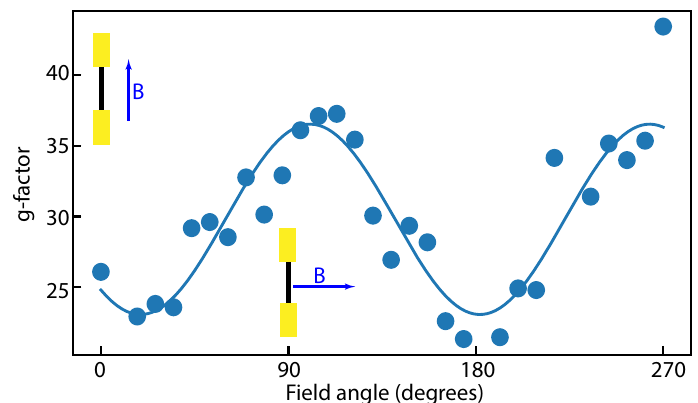
Figure 4: Effective Landé g-factor dependence on field angle for device 2. Graphics illustrate relative orientation of nanowire and magnetic field. Solid line is a sinu- soidal fit with an offset of 29.8 and an amplitude of 6.7. Values extracted for state A in Fig.S6